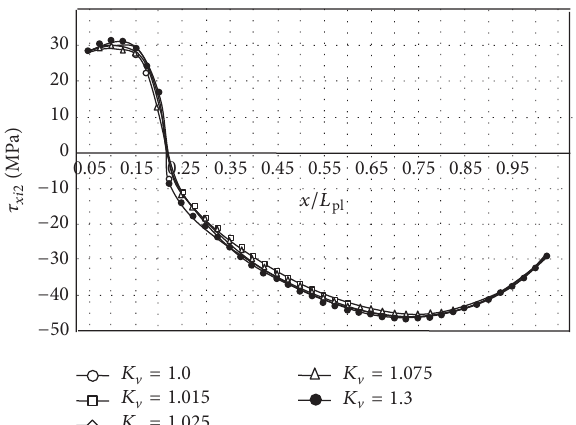
Figure 5: The calculated distributions of tangential contact stresses on the roller electrode along the zone of the surfacing, depending on thespeedasymmetrycoefficient(theinitialthicknessofthecompact material is 0.5 mm).